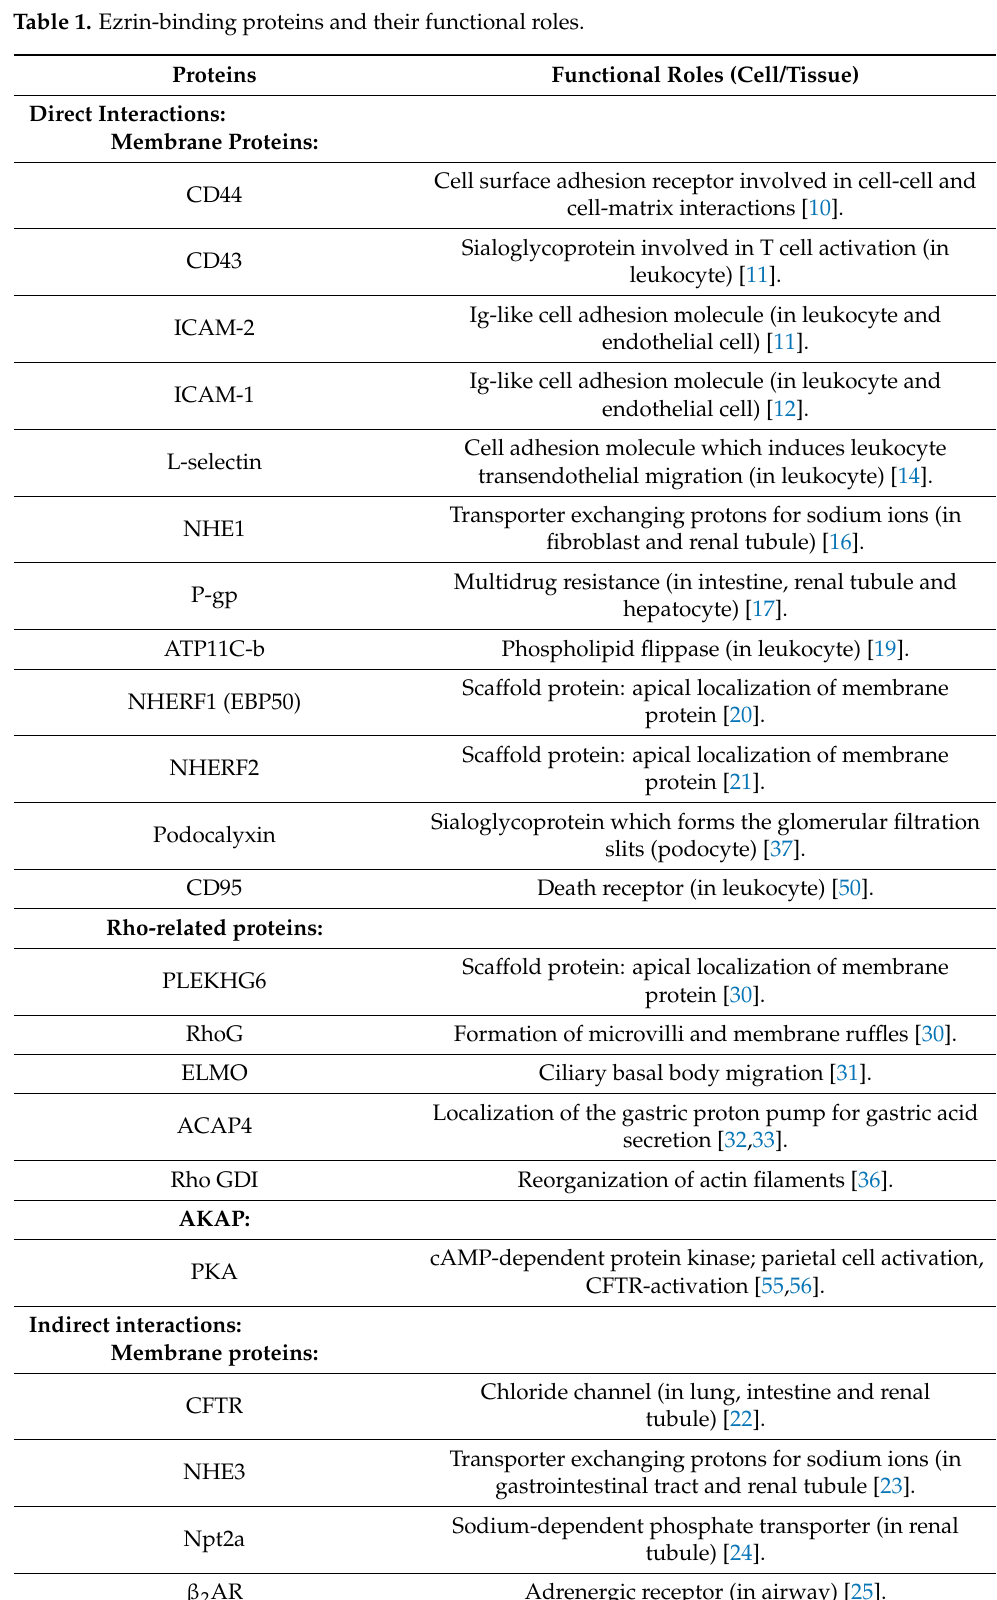
Table 1. Ezrin-binding proteins and their functional